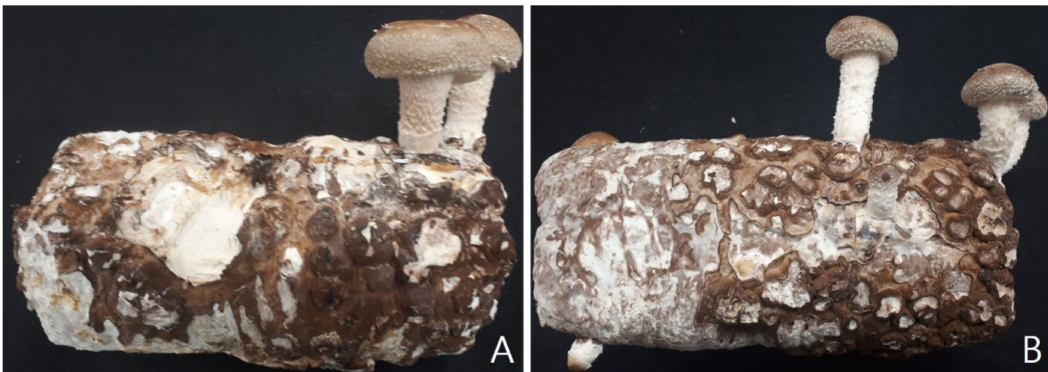
Figure 1. Fruit body of Lentinula edodes (LE) in Blue light (BL)and Lightless (LL) conditions. ( A ): BL, ( B ): LL.